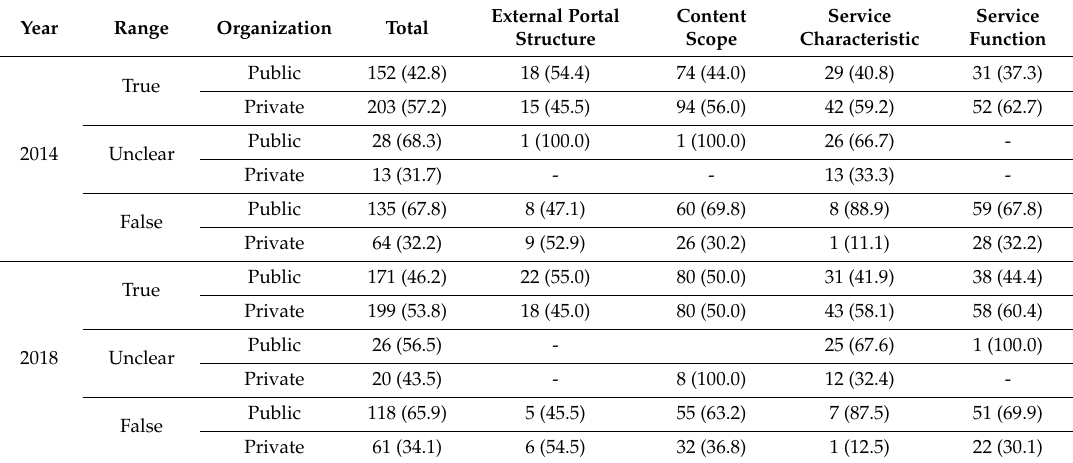
Table 2. Comparison of private and public in 2014 and 2018 (frequency,